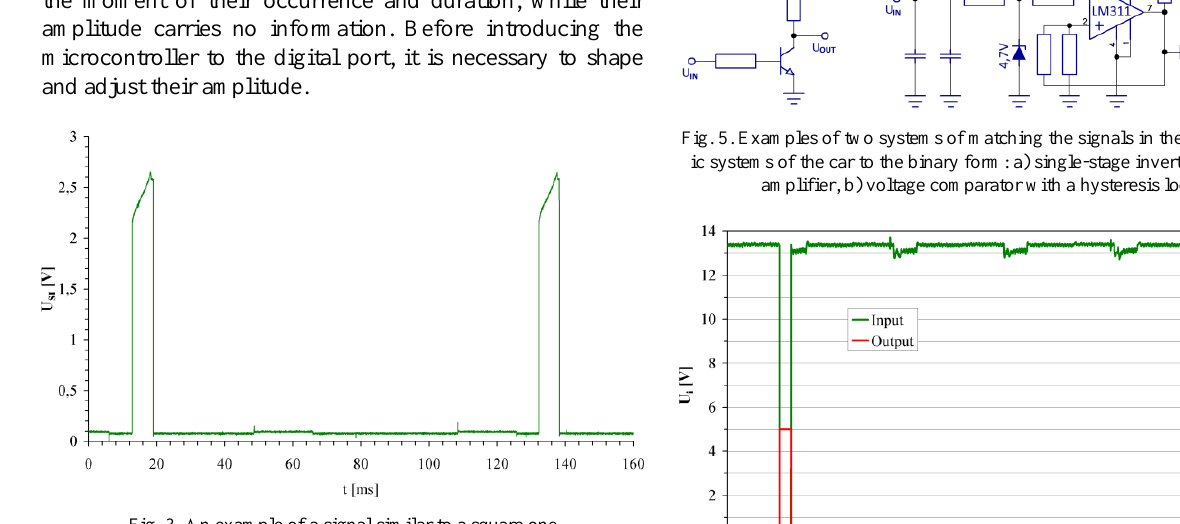
Fig. 3. An example of a signal similar to a square one